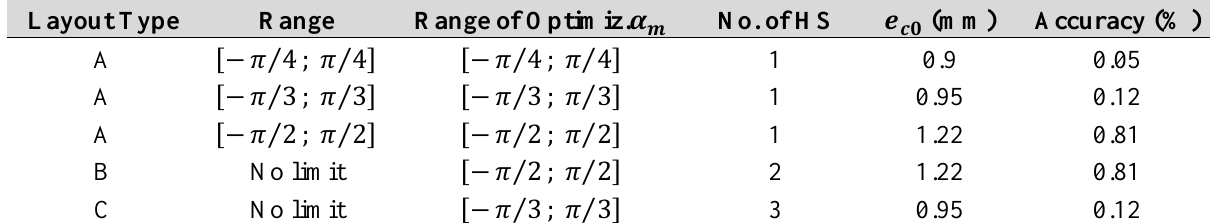
Table 1. Comparison between different optimized layout for an assigned magnet with cylindrical shape (